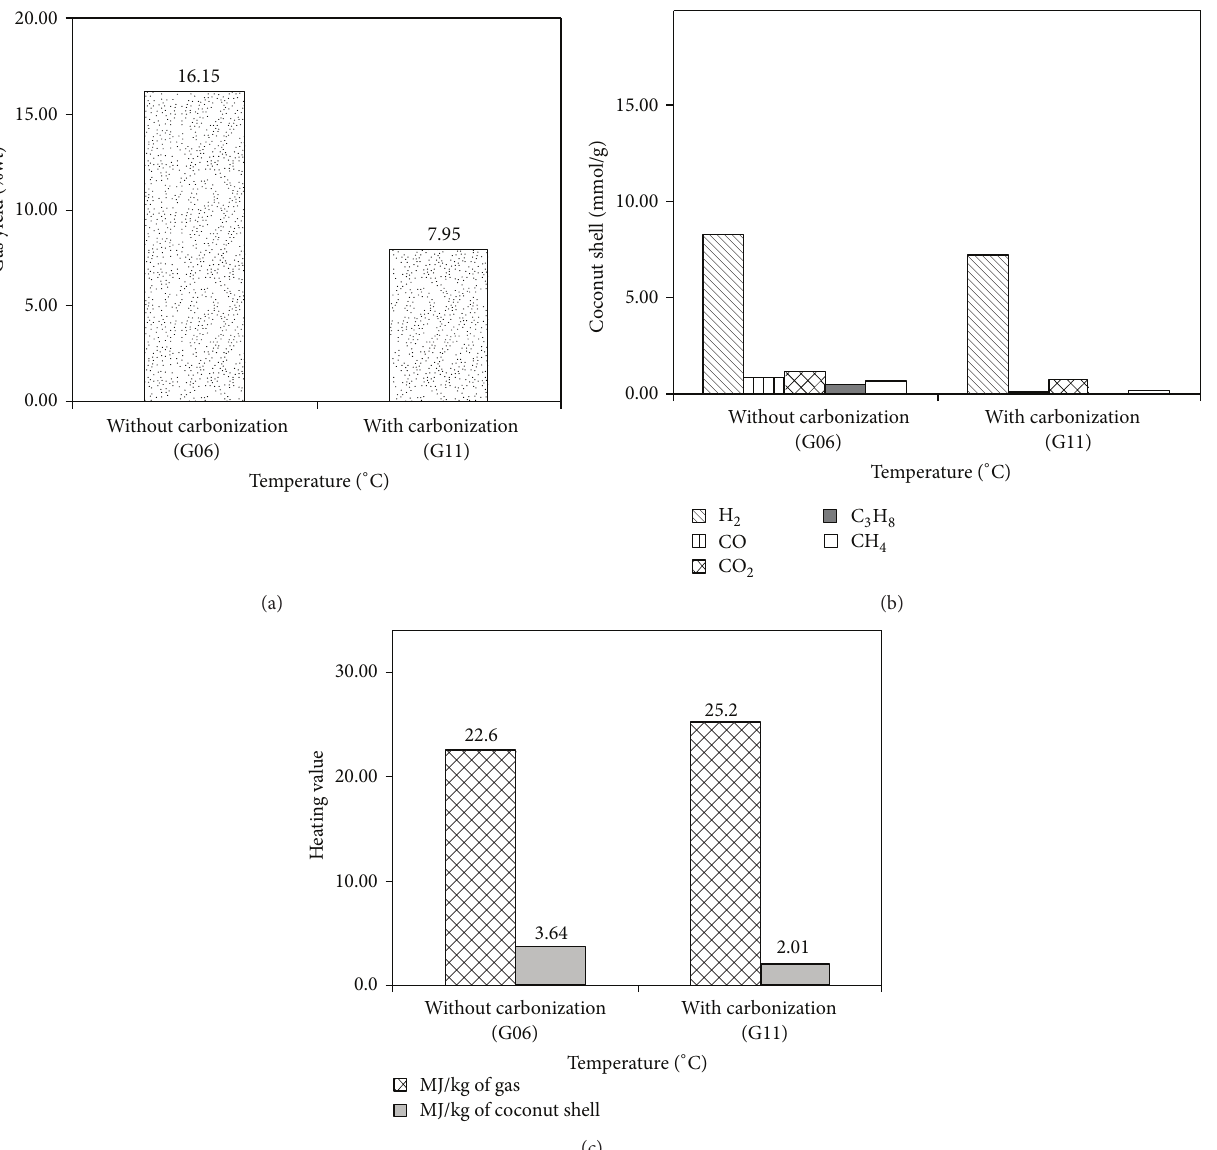
Figure 5: Effect of carbonization step on (a) gas yield, (b) gas composition, and (c) heating value of gas products from gasification of coconut shell with 50% CO 2 at 600 ∘ C for 180min and chemical ratio of